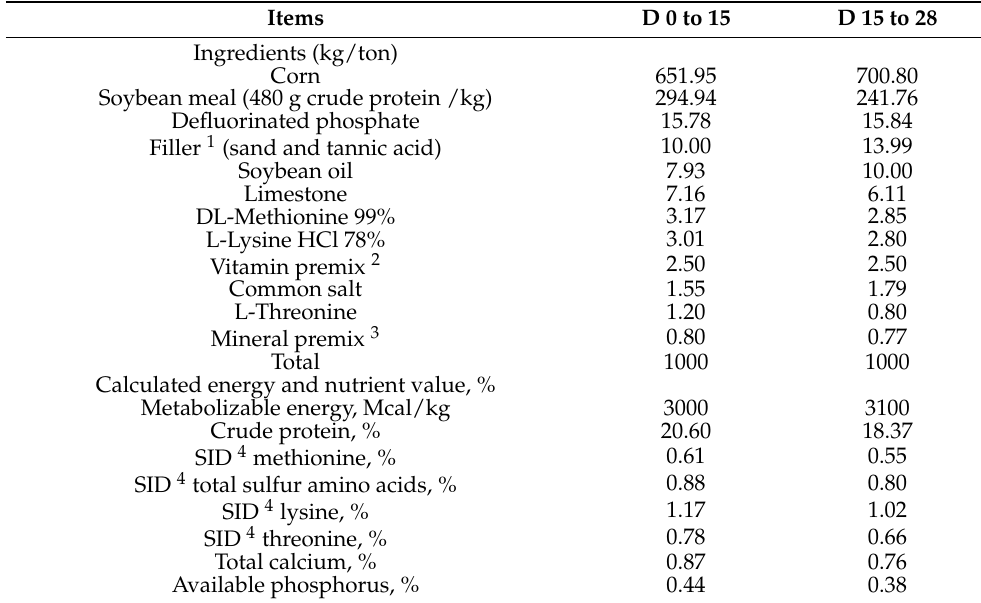
Table 1. Ingredients and nutrient compositions of basal diets (as-fed